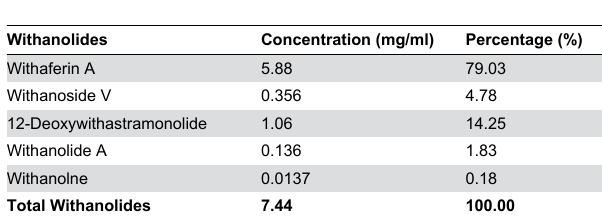
Table 1. Withanolides in WRE by